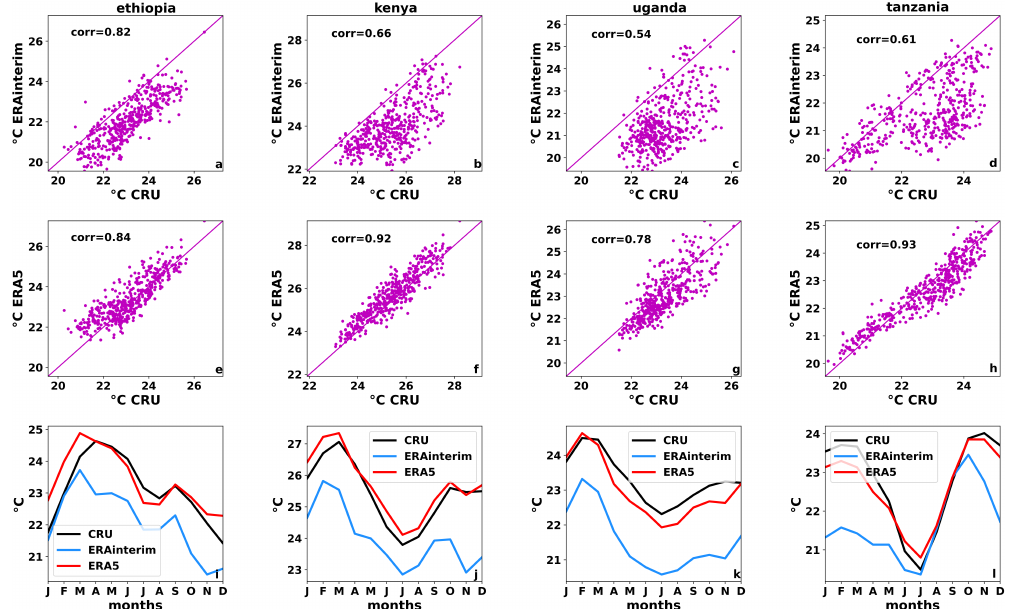
Figure 13. Monthly mean near-surface temperature from 1981 to 2017 in observations (CRU) versus ERA-interim ( a – d ) and ERA5 ( e – h ) in the four focus countries (columns). Annual cycle of monthly mean near-surface temperature ( i – l ) averaged over the corresponding country as observed (black line), in ERA-interim (blue line) and ERA5 (red